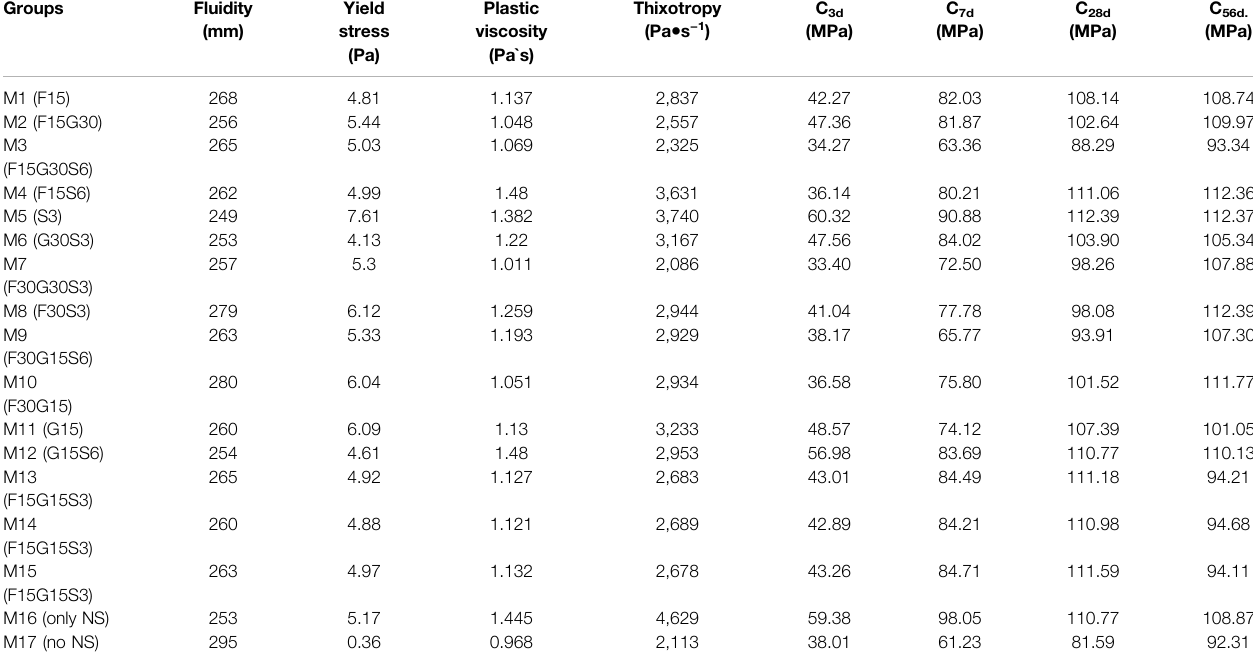
TABLE 4 | Experimental results of nano-silica modi fi ed cement-based paste containing SCMs, fl uidity. Groups